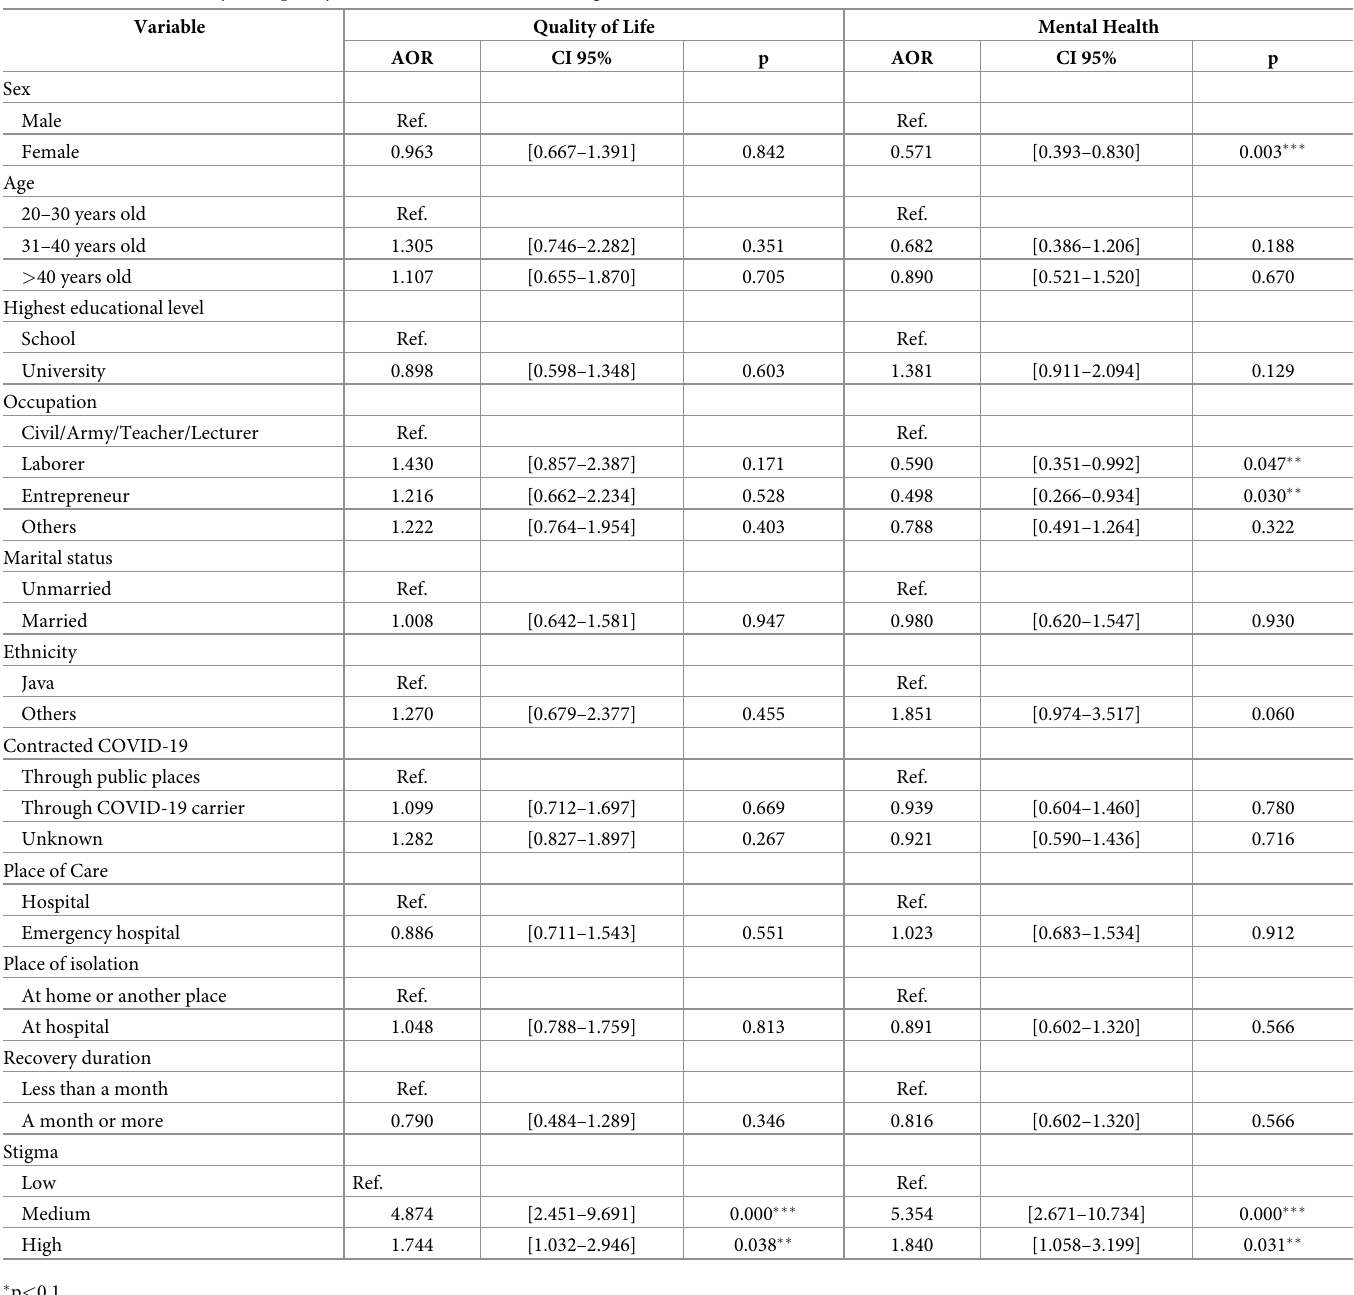
Table 3. Multivariate analysis of quality of life and mental health among COVID-19 survivors in